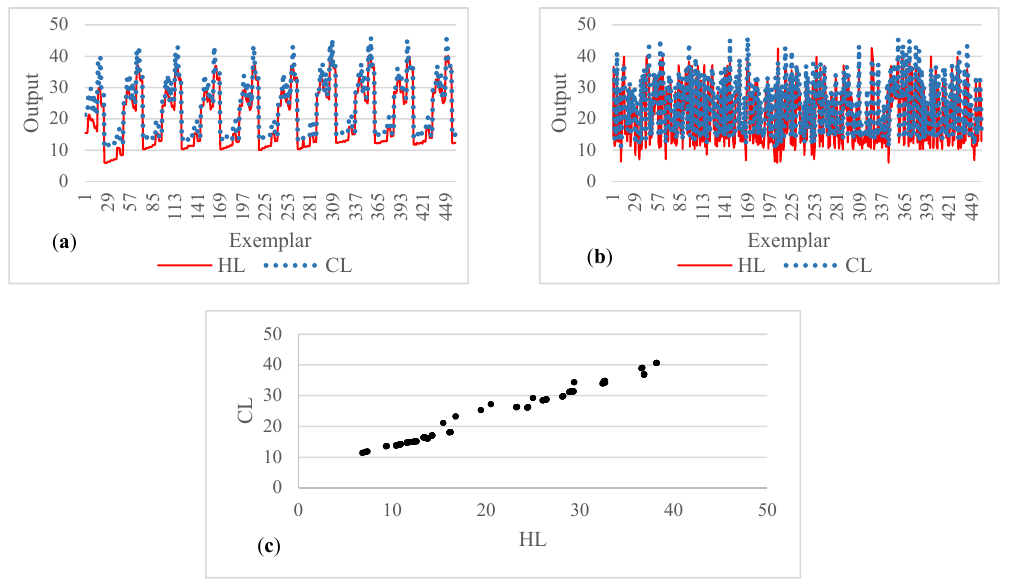
Figure 1. Training Records: ( a ) Actual output of heating load (HL) and cooling load (CL); ( b ) Randomized output of HL and CL; ( c ) Scatter